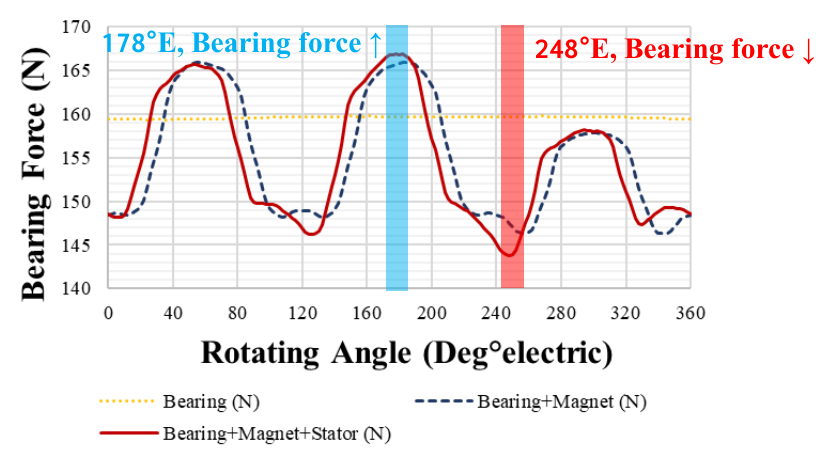
Figure 4. Bearing force waveform according to magnetomotive force.